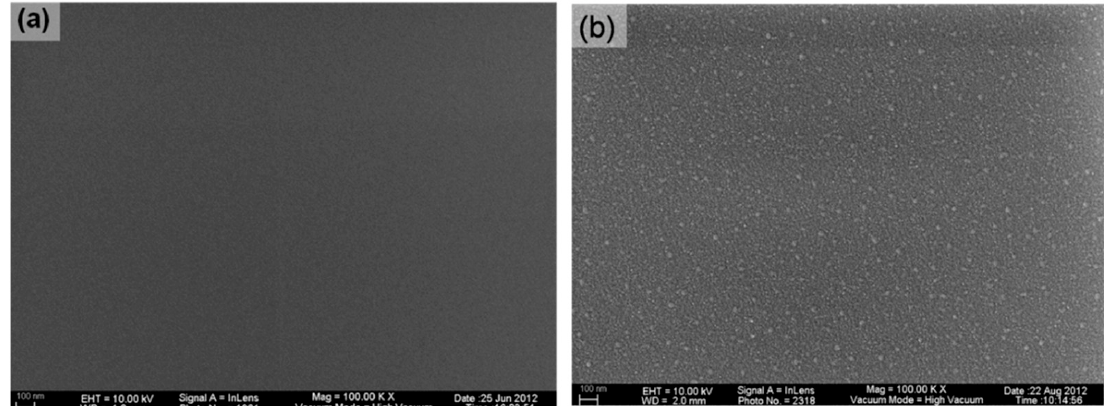
Figure 7. Surface morphologies of Mo-DLC coatings on Si substrate: ( a ) 3.9 at.% Mo and ( b ) 16.2 at.% Mo.